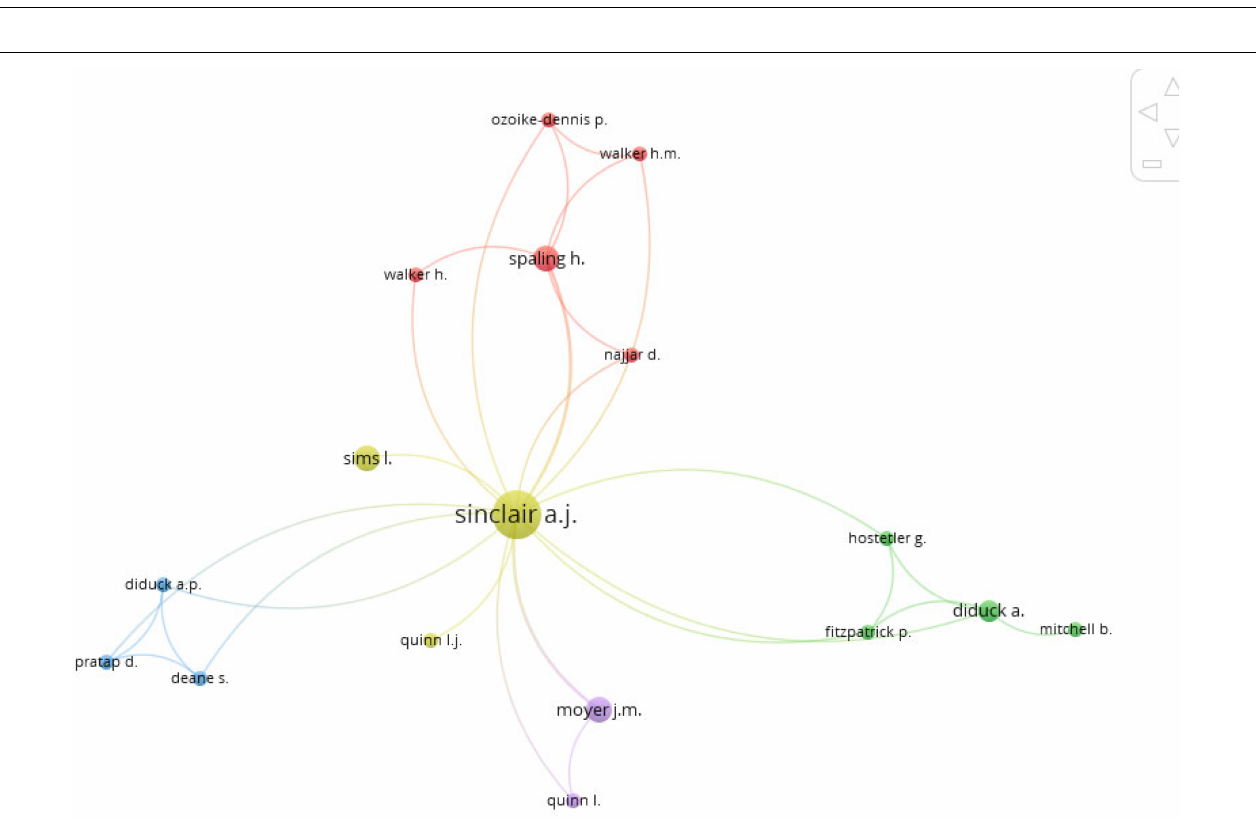
FIGURE 6 | Co-authorship network (only authors who collaborate in the publication of a document are shown in the image; prepared by authors).